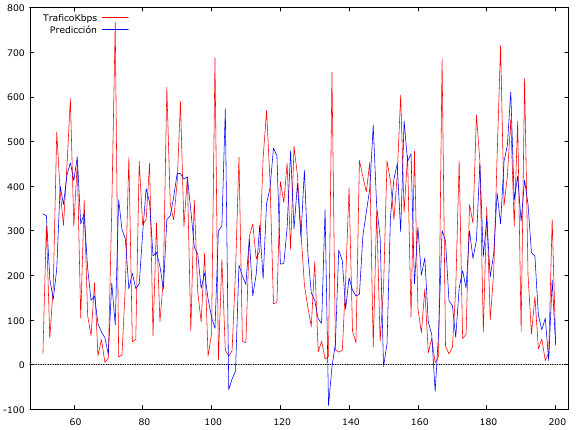
Figure 9. Prediction and fit for the ARIMA model (2,1,32).